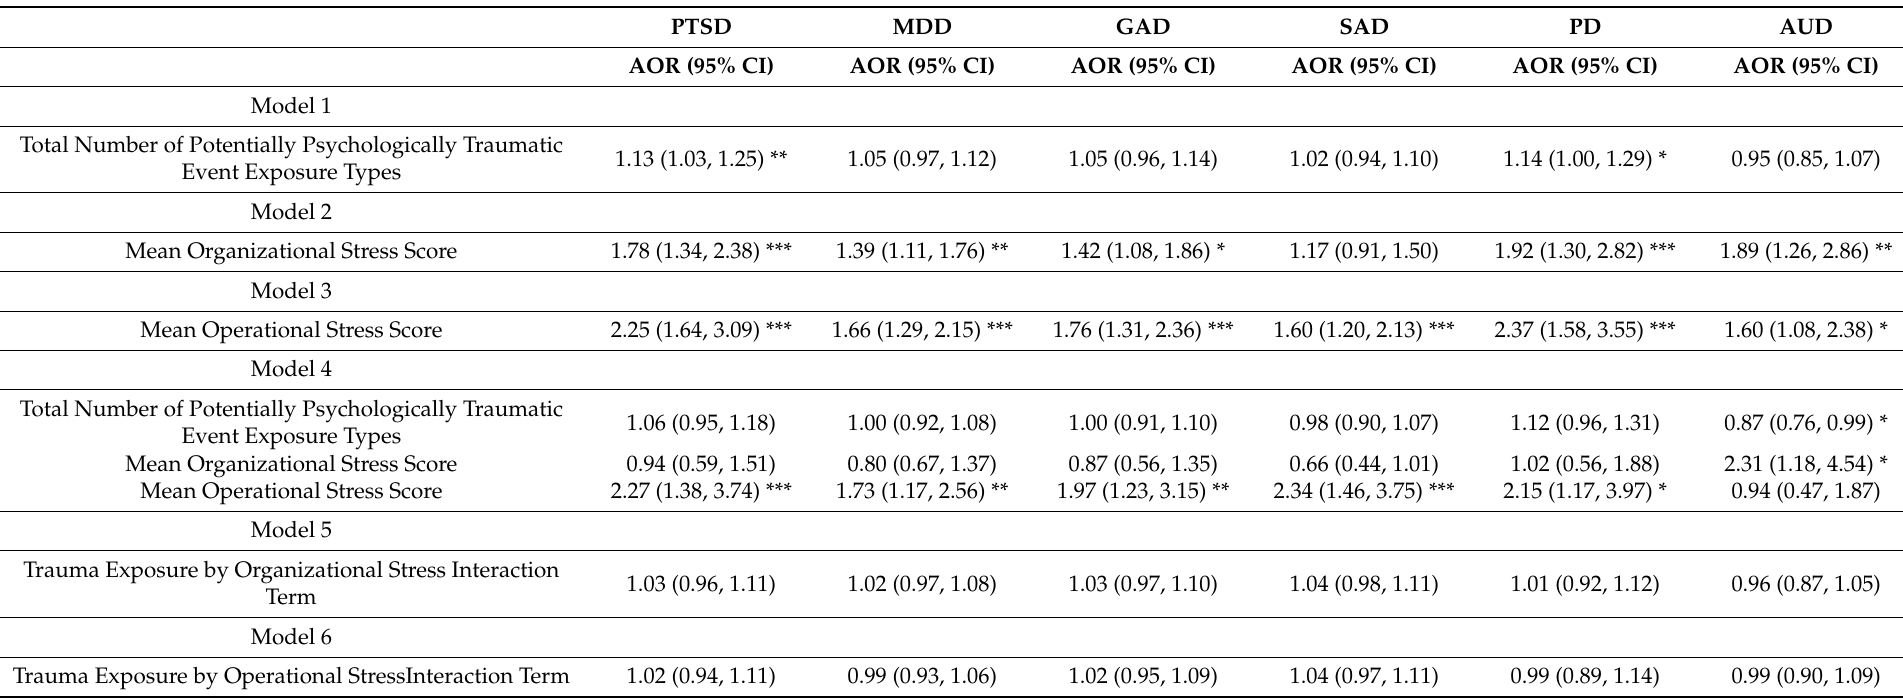
Table 5. Association Between Potentially Psychologically Traumatic Event Exposures, Organizational Stressors, Operational Stressors, and Positive Screens for Mental Health